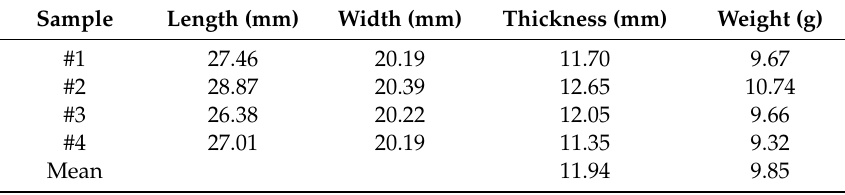
Figure 6. Detailed comparison of 40 and 64 wt.% Gc specimens. Table 3. Dimensions of specimens taken from designed hull plate with Gc of 40 wt.%.